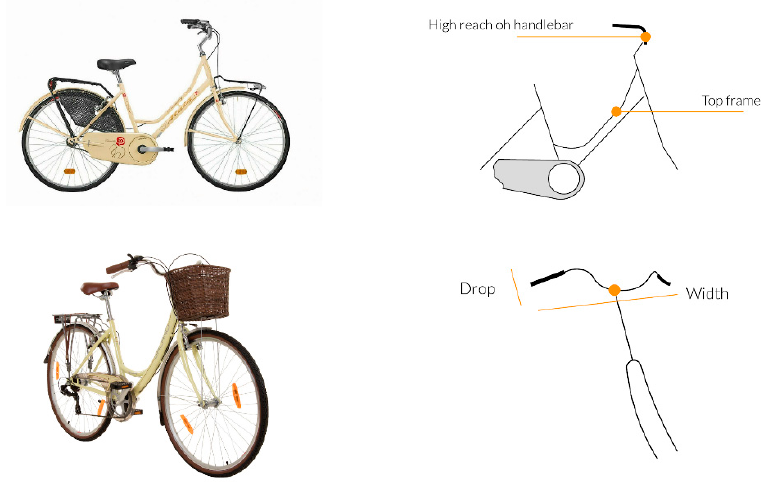
Figure 11. Stylistic references for the retro style—the Atala Piccadilly.